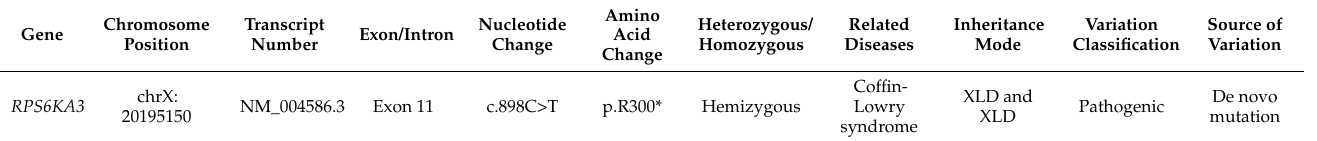
Table 1. Proband sequencing results.